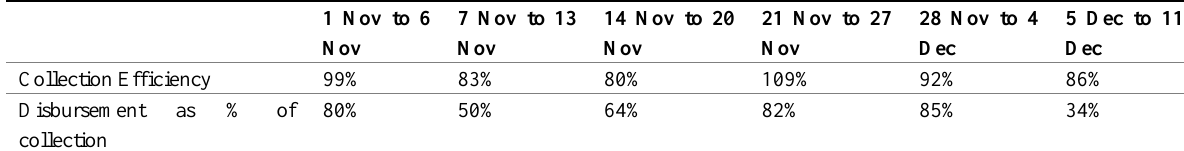
Table 1: Collection and Disbursements by MFIs